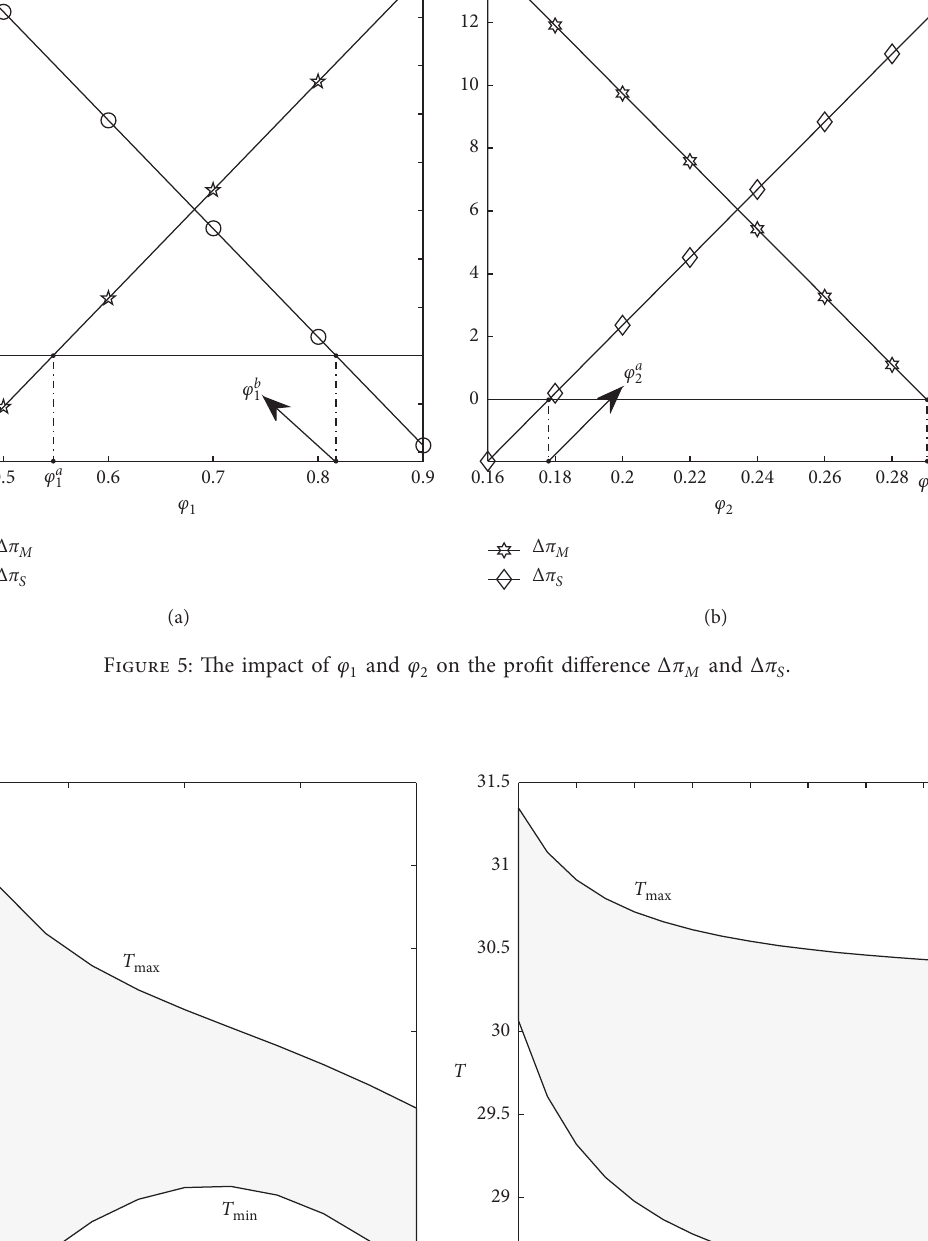
Figure 6: The impact of λ and k on transfer payment.